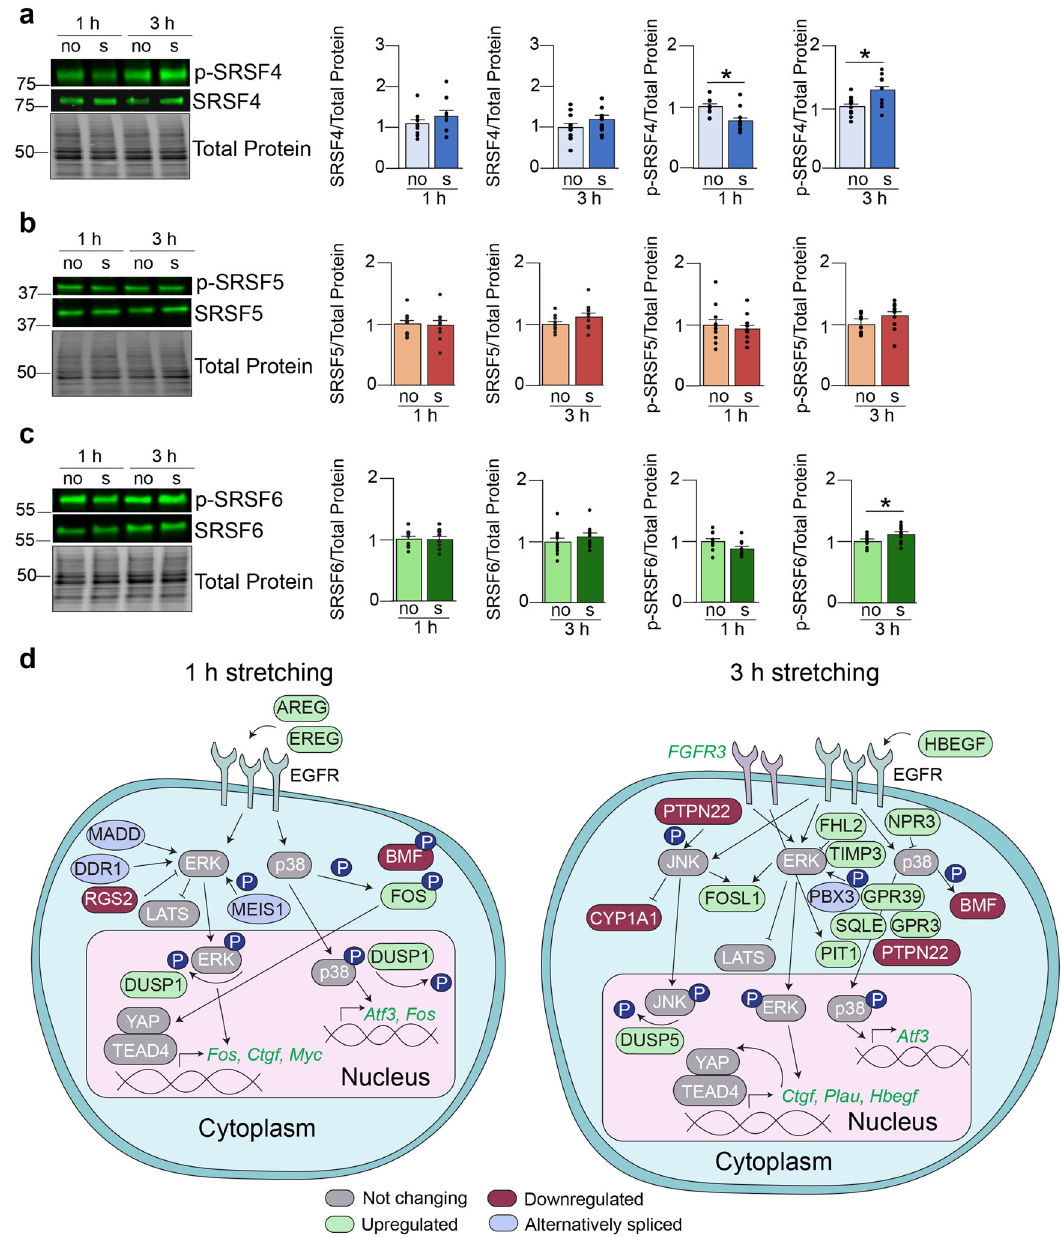
Fig. 7 SRSF4 is a mechanosensitive RBP. Differentiated muscle cells were stretched for 1 h or 3 h and western blot assays were performed and quanti fi ed by densitometry to examine total and phosphorylated levels of SRSF4 ( a ), SRSF5 ( b ), and SRSF6 ( c ). no: non-stretched samples. s: stretched samples. d Some overlapping genes and splicing events from the SRSF4 pie charts shown in Fig. 6c were depicted in cartoons for 1 h and 3 h stretching time points showing how mechanosensitive targets and those regulated by SRSF4 might play a role in the MAPK signaling cascade. ATF3 activating transcription factor 3, AREG amphiregulin, BMF Bcl2 modifying factor, CYR61 cysteine-rich angiogenic inducer 61, CYP1A1 cytochrome p450 family 1 subfamily A member 1, CTGF connective tissue growth factor, DDR1 discoidin domain receptor tyrosine kinase 1, DUSP1 dual speci fi city phosphatase 1, DUSP5 dual speci fi city phosphatase 5, EGFR epidermal growth factor receptor, ERK extracellular signal-regulated kinase, EREG epiregulin, FGFR3 fi broblast growth factor receptor 3, FHL2 four and a half LIM domains 2, FOS Fos proto-oncogene AP-1 transcription factor subunit, FOSL1 FOS like 1 AP-1 transcription factor subunit, GPR3 G-protein coupled receptor 3, GPR39 G-protein coupled receptor 39, HBEGF heparin binding EGF like growth factor, LATS large tumor suppressor kinase 1, JNK c-Jun N-terminal kinase, MADD MAP kinase activating death domain, MEIS meis homeobox 1, MYC MYC proto-oncogene, NPR3 natriuretic peptide receptor 3, PBX3 PBX homeobox 3, PIT1 pituitary transcript factor 1, PLAU plasminogen activator urokinase, PTPN22 protein tyrosine phosphatase non- receptor type 22, P38 p38 mitogen-activated protein kinase, RGS2 regulator of G-protein signaling 2, SQLE squalene epoxidase, TEAD4 TEA-domain transcription factor 4, TIMP3 TIMP metallopeptidase inhibitor 3, YAP yes-associated protein. Results are shown as mean ± SEM, N = 4 ( a ), N = 4 ( b ), N = 4 ( c ) * p < 0.05, Welch ’ s T